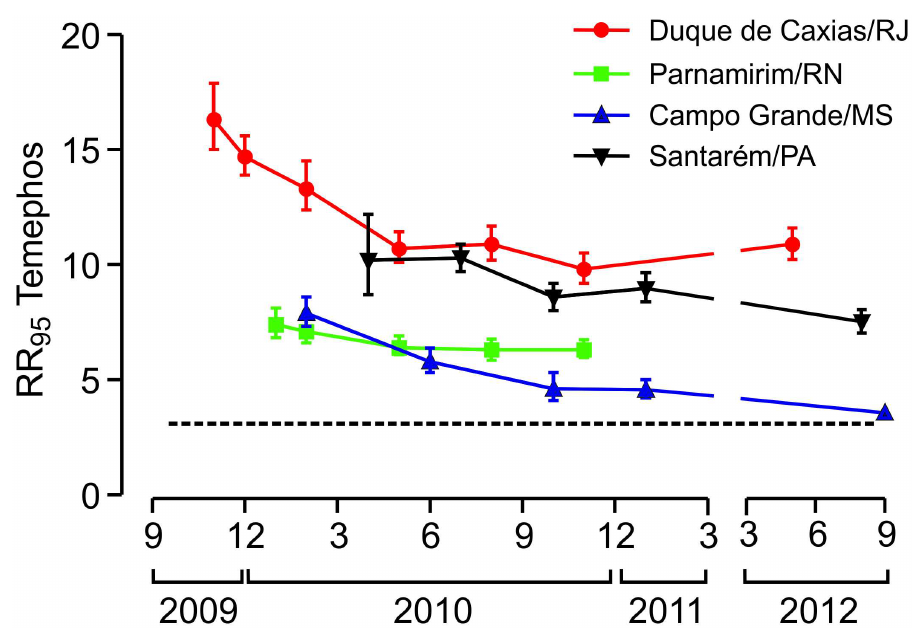
Fig 2. Temporal evaluation of temephos susceptibility status of four Brazilian Ae . aegypti populations. Each point indicates the Resistance Ratio (RR 95 ) and the 95% confidence interval. The dashed line, at RR 95 = 3.0, points to the threshold that triggers interruption of temephos application, according to the Brazilian Health Ministry